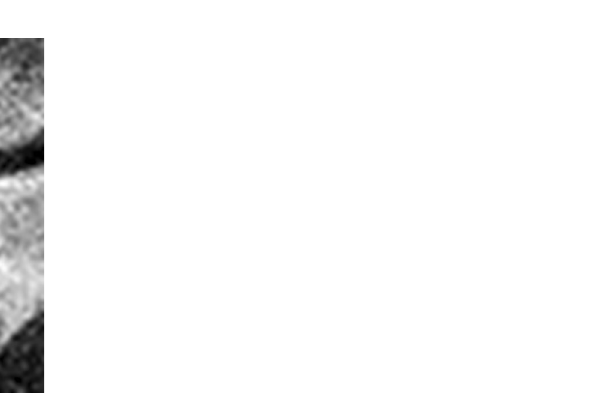
Figure 5. Modiolar electrode, first turn, HFMS SV Position. Star represents diminishing electrode signal, arrow represents basilar membrane.